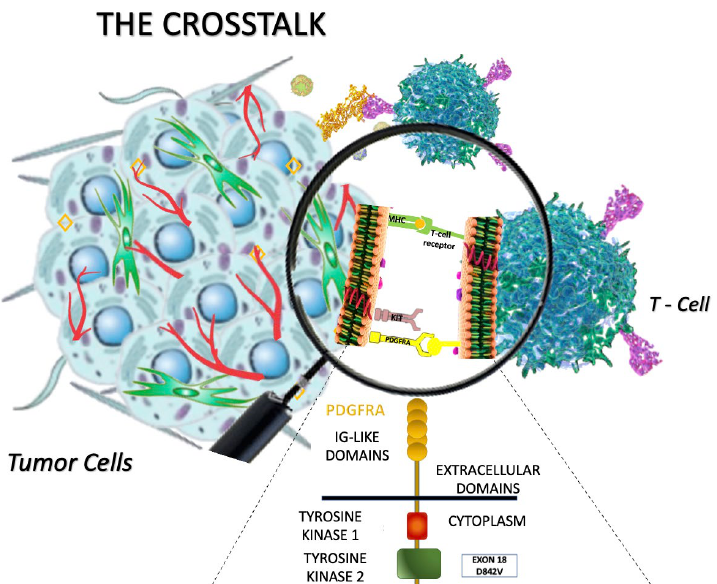
Figure 2. The crosstalk between tumor cells and T lymphocytes in GIST. PDGFRA-mutant GISTs, compared to KIT-mutant GISTs, show an increased number of immune cells (such as NK+, CD4+, and CD8+ lymphocytes) and higher production of immunogenic neo-antigens, leading to increased tumor regression (based on Vitiello et al.) [5].